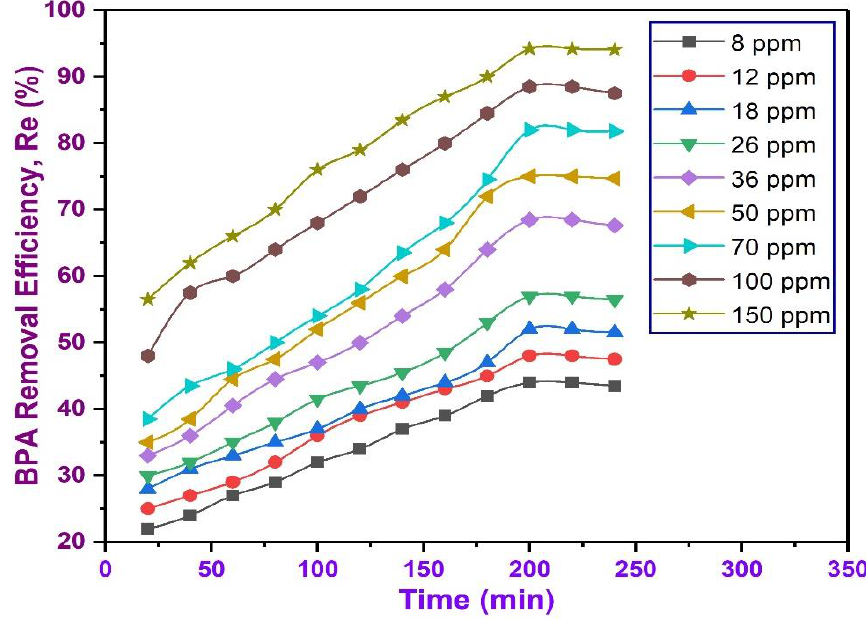
Figure 10. Effects of initial BPA concentrations on the removal efficiency under varying initial con- centrations (8–150 ppm) at constant pH (6.0), dosage (0.5 g), and varying contact times (20–240 min).